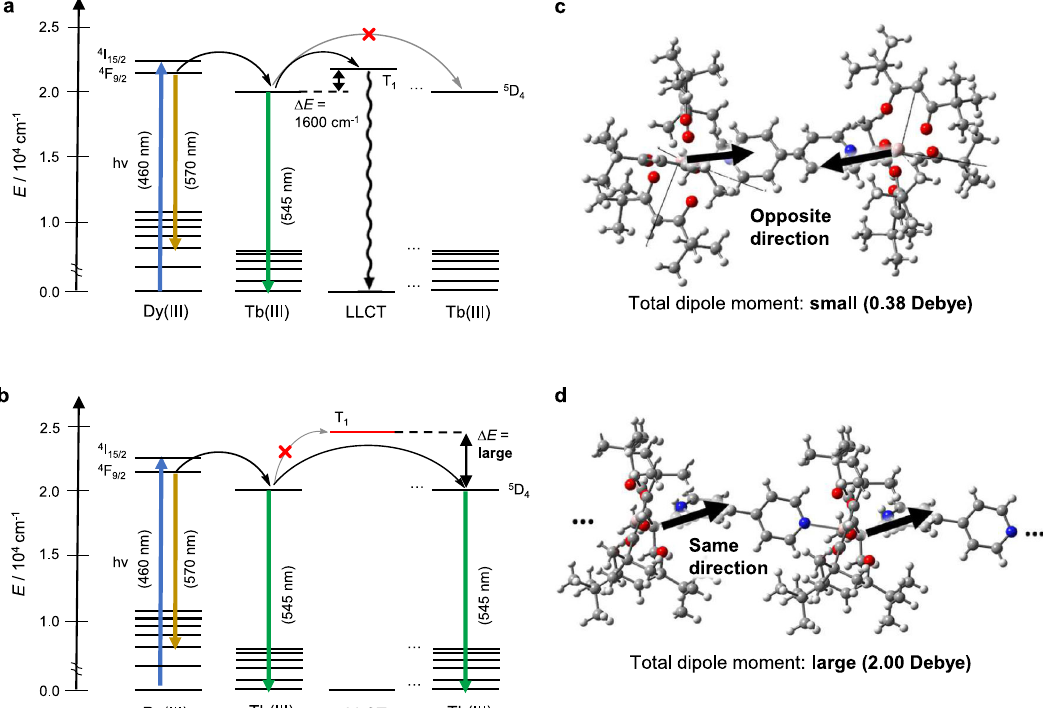
Fig. 5 Energy migration process. Energy diagram of the excited states in the a Dy(III)-Tb(III) dinuclear complex and b Dy(III)-Tb(III) coordination polymer based on the density functional theory calculations. The dipole moment calculated for each Tb(tmh) 3 center is based on the c dinuclear, and d polymer structures. Gray spheres represent carbon; white spheres, hydrogen; red spheres, oxygen; blue spheres, nitrogen and green spheres, terbium. Dy(III), dysprosium ion; Tb(III), terbium ion; tmh, 2,2,6,6-tetramethyl-3,5-heptanedionato; LLCT, ligand-to-ligand charge